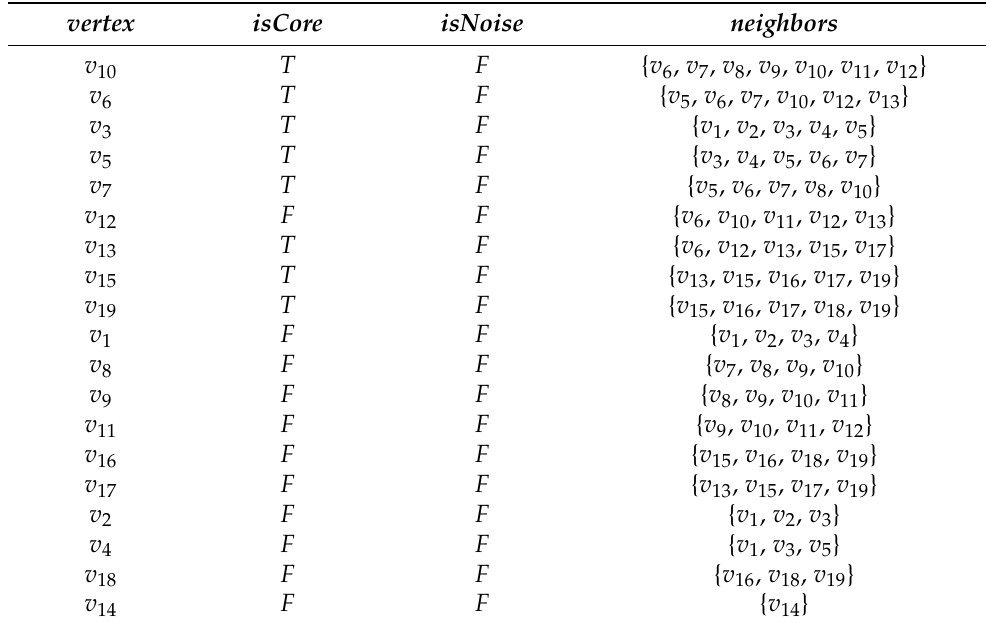
Table 2. Sorted NNG .